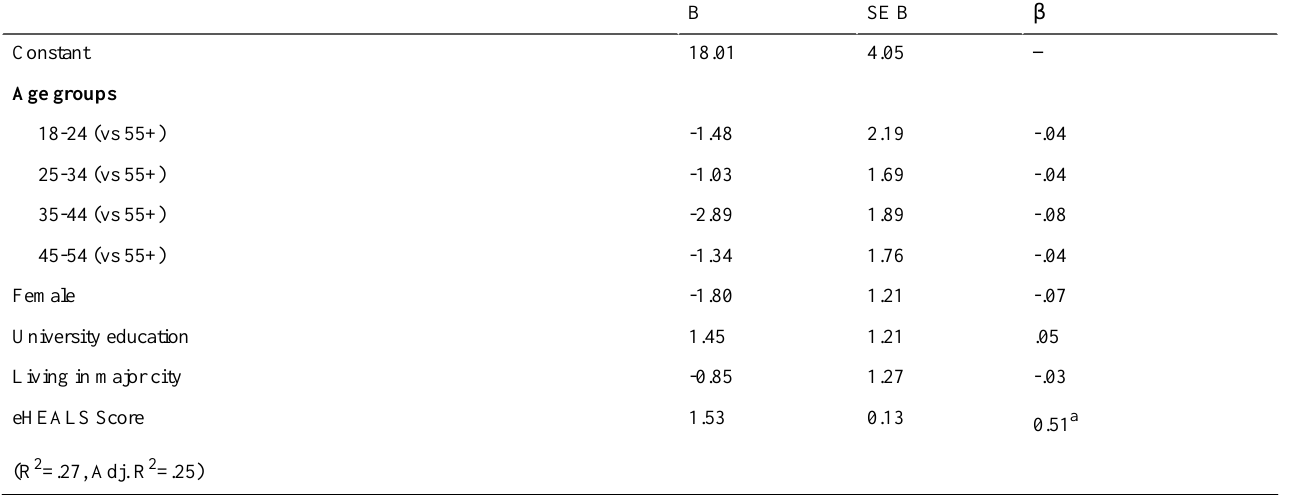
Table 7. PAM-13 score vs eHEALS score, and demographic